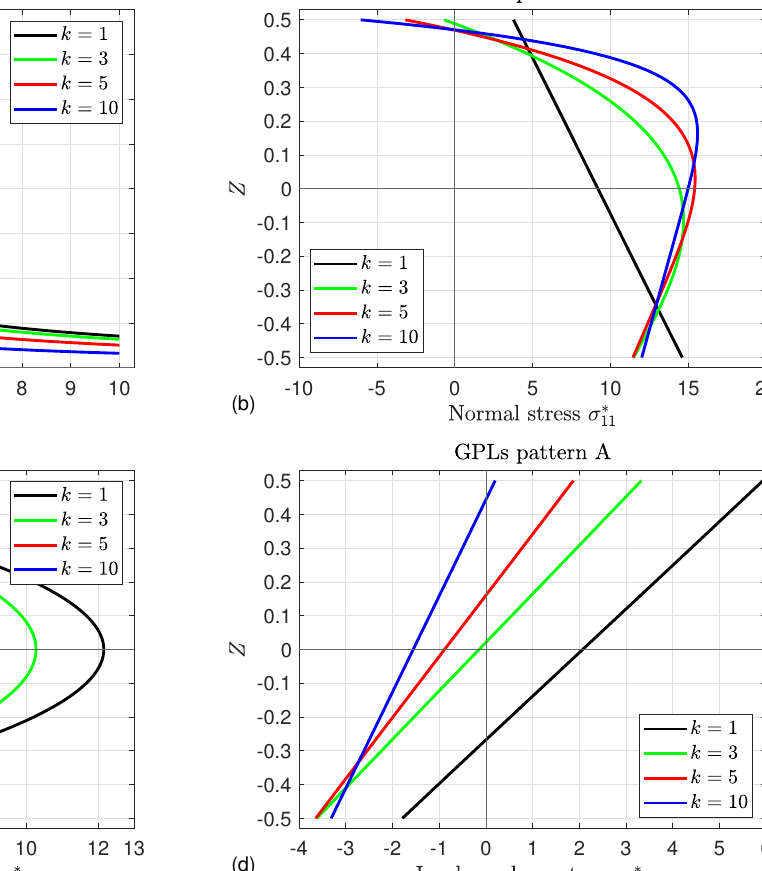
Figure 13. Influence of the temperature exponent k on ( a ) the central deflection W ∗ , ( b ) the normal stress σ ∗ , ( c ) the transverse shear stress σ ∗ 11 nanocomposite piezoelectric square plates.